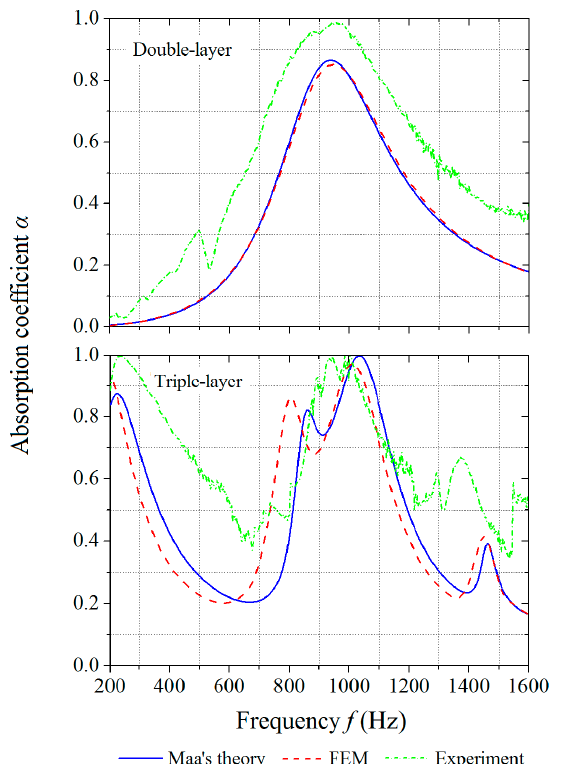
Figure 12. Absorption coefficients of optimized MPPs obtained by theoretical predictions, numerical simulations, and experiments: ( top ) double-layer MPP and ( bottom ) triple-layer MPP.